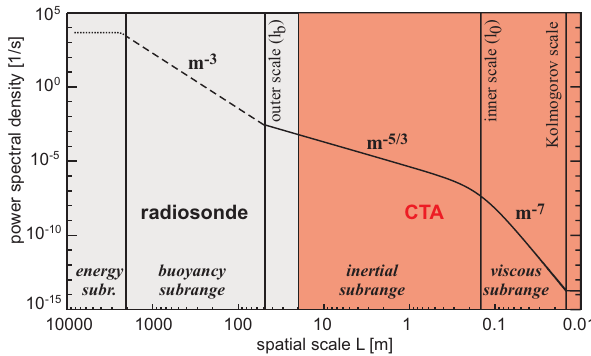
Fig. 1. Theoretical turbulent spectrum for 20km altitude. In con- trast to a standard radiosonde, the constant temperature anemometer (CTA) provides measurement of the spectrum down to the viscous